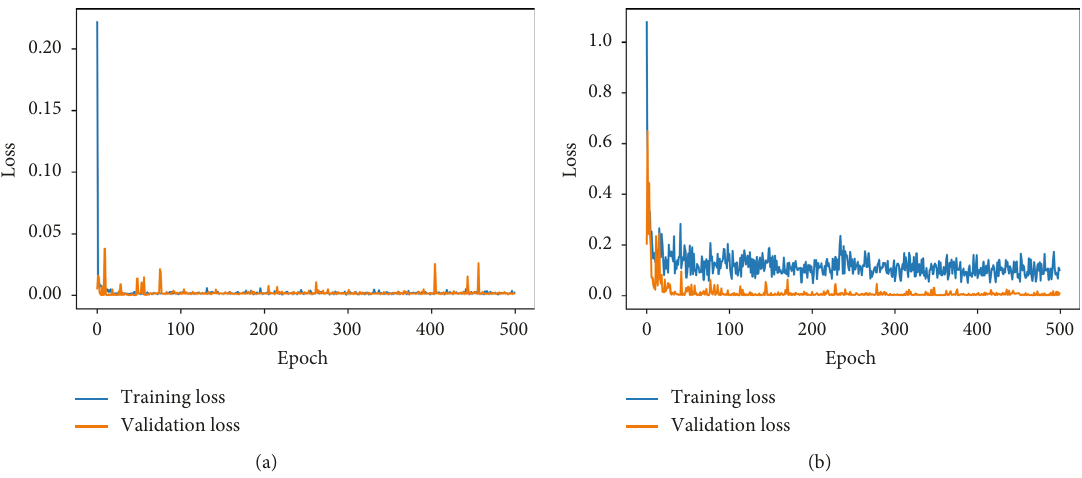
Figure 15: The Training Processes of the Proposed Models on AAIA ′ 16 seismic: (a) DCTCNN; (b)